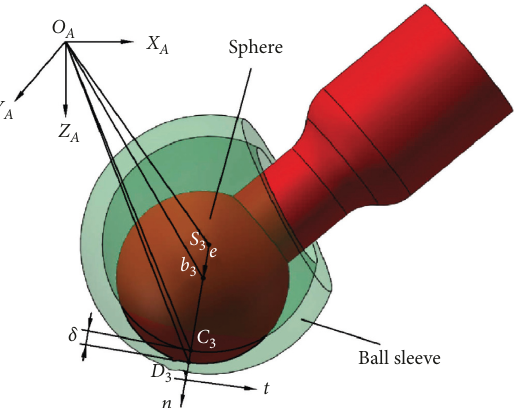
Figure 3: Spherical joint clearance with contact.